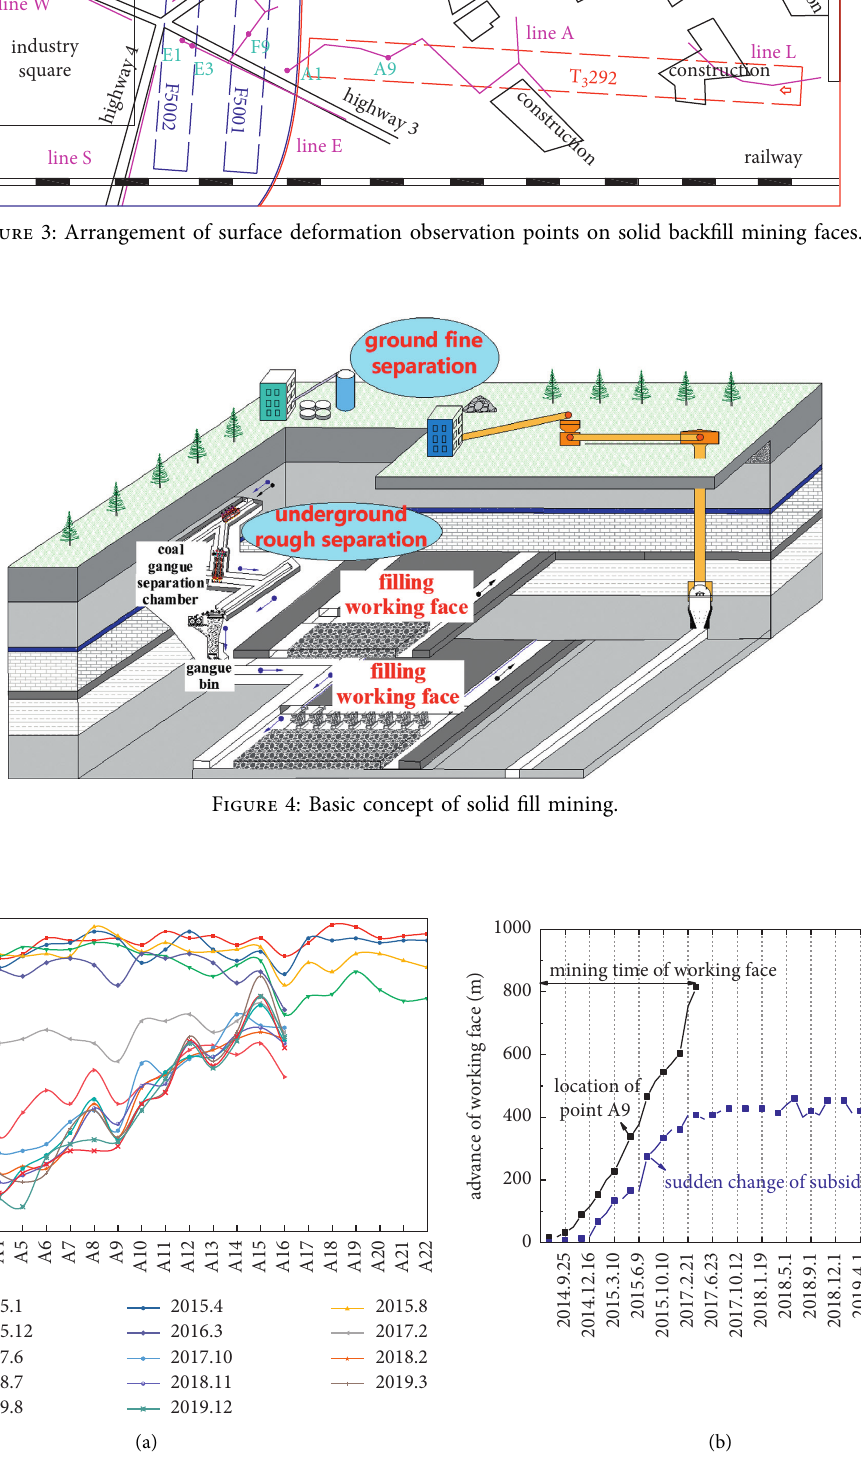
Figure 5: Surface subsidence values (a) on line A for each time period and (b) for each time period at measuring point A